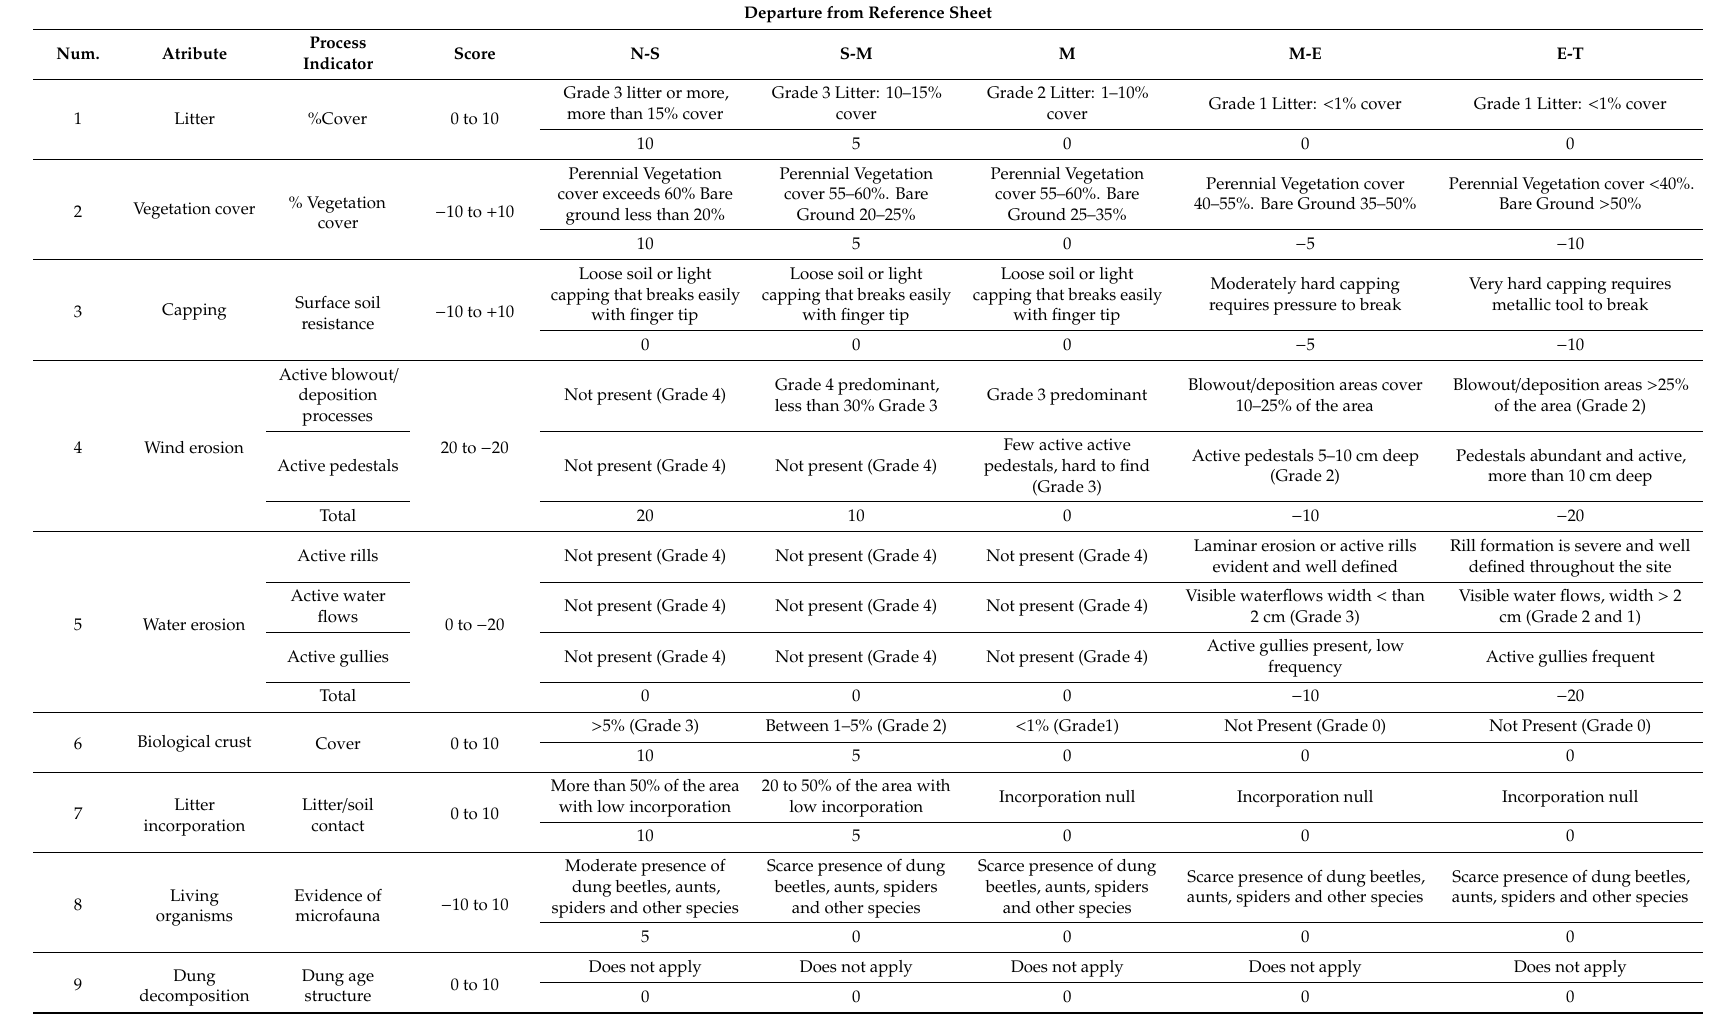
Table A2. Evaluation Matrix (Subandean Grassland